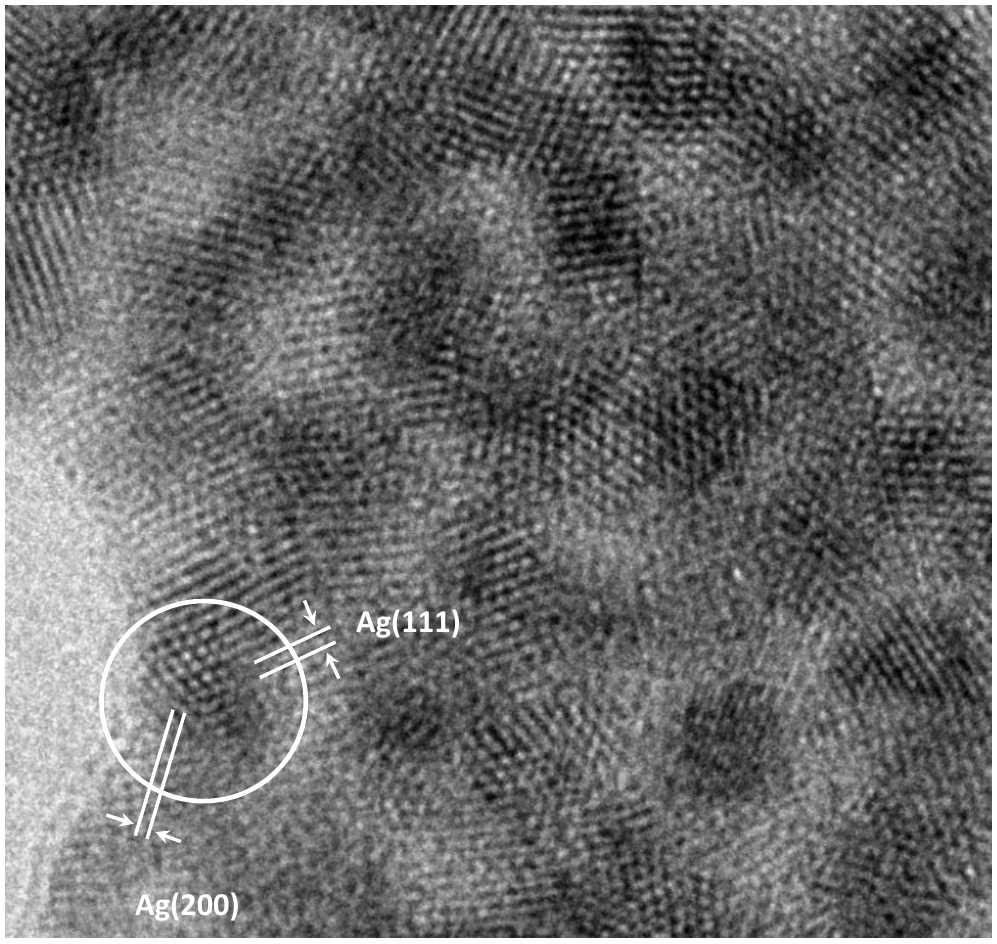
Figure 2. An enlarged image of the regions of ordered atoms on a surface, marked with a square in Figure 1.